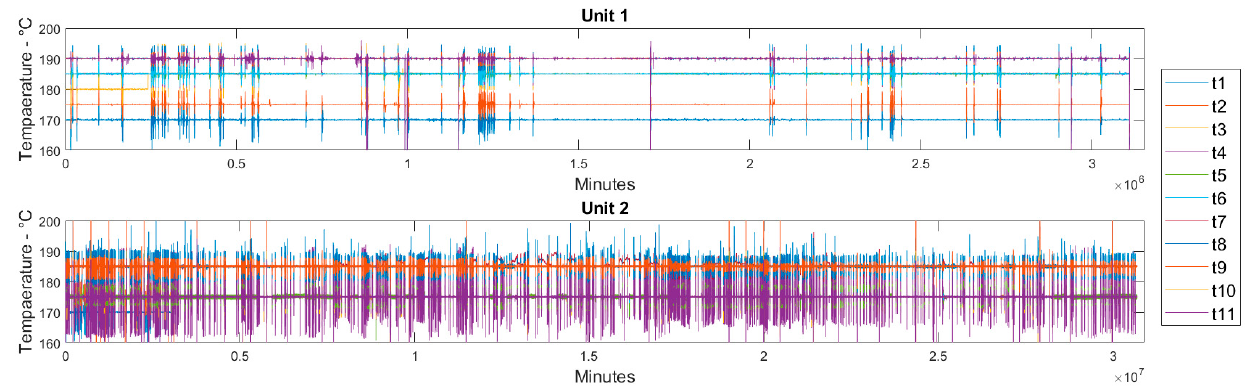
Figure 4. Temperature signals collected during the two nominal conditions by M1 (on the top ) and M2 (on the bottom ).